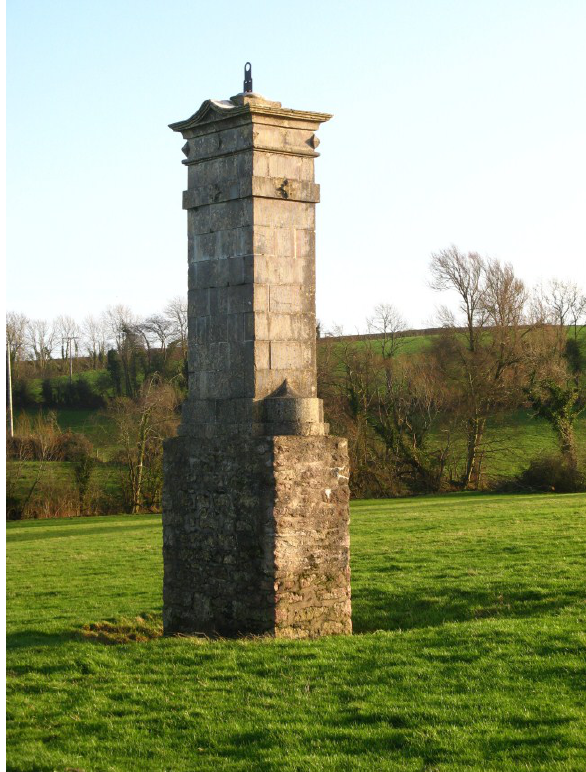
Figure 8: The Southern Meridian Mark for the Transit Instrument at Ballyheridan from the north-west. The stone